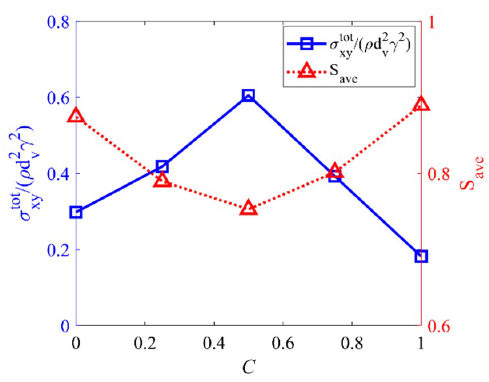
Figure 15. The average normalized shear stress and the average order parameter S ave as a function of rods fraction C for the binary mixtures of AR = 0.15 and AR = 6. The solid volume fraction is ν = 0.55.